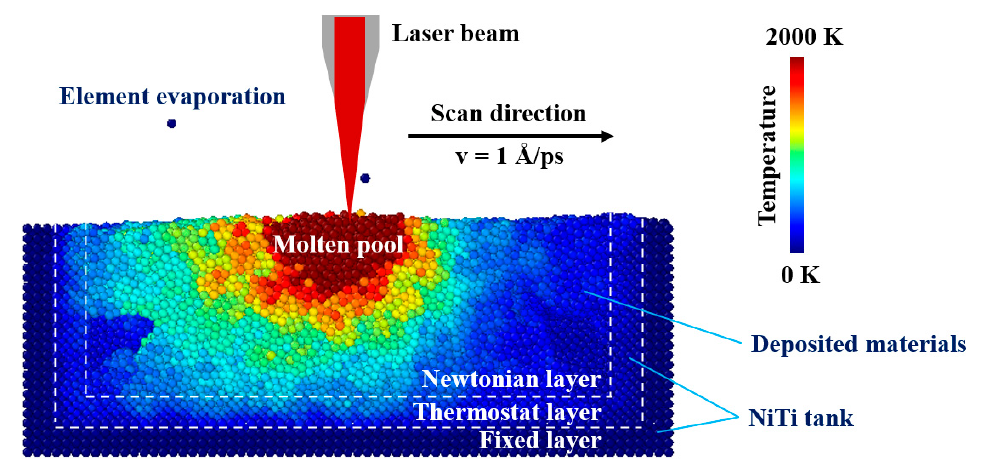
Figure 3. Laser powder bed fusion process simulated using MD models.